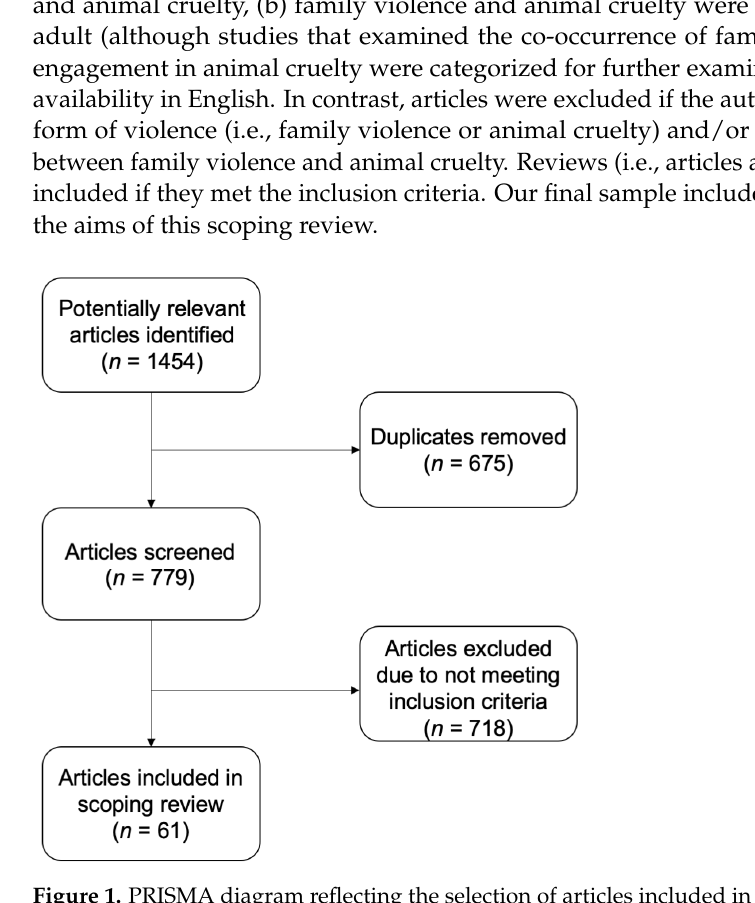
Figure 1. PRISMA diagram reflecting the selection of articles included in the current study.